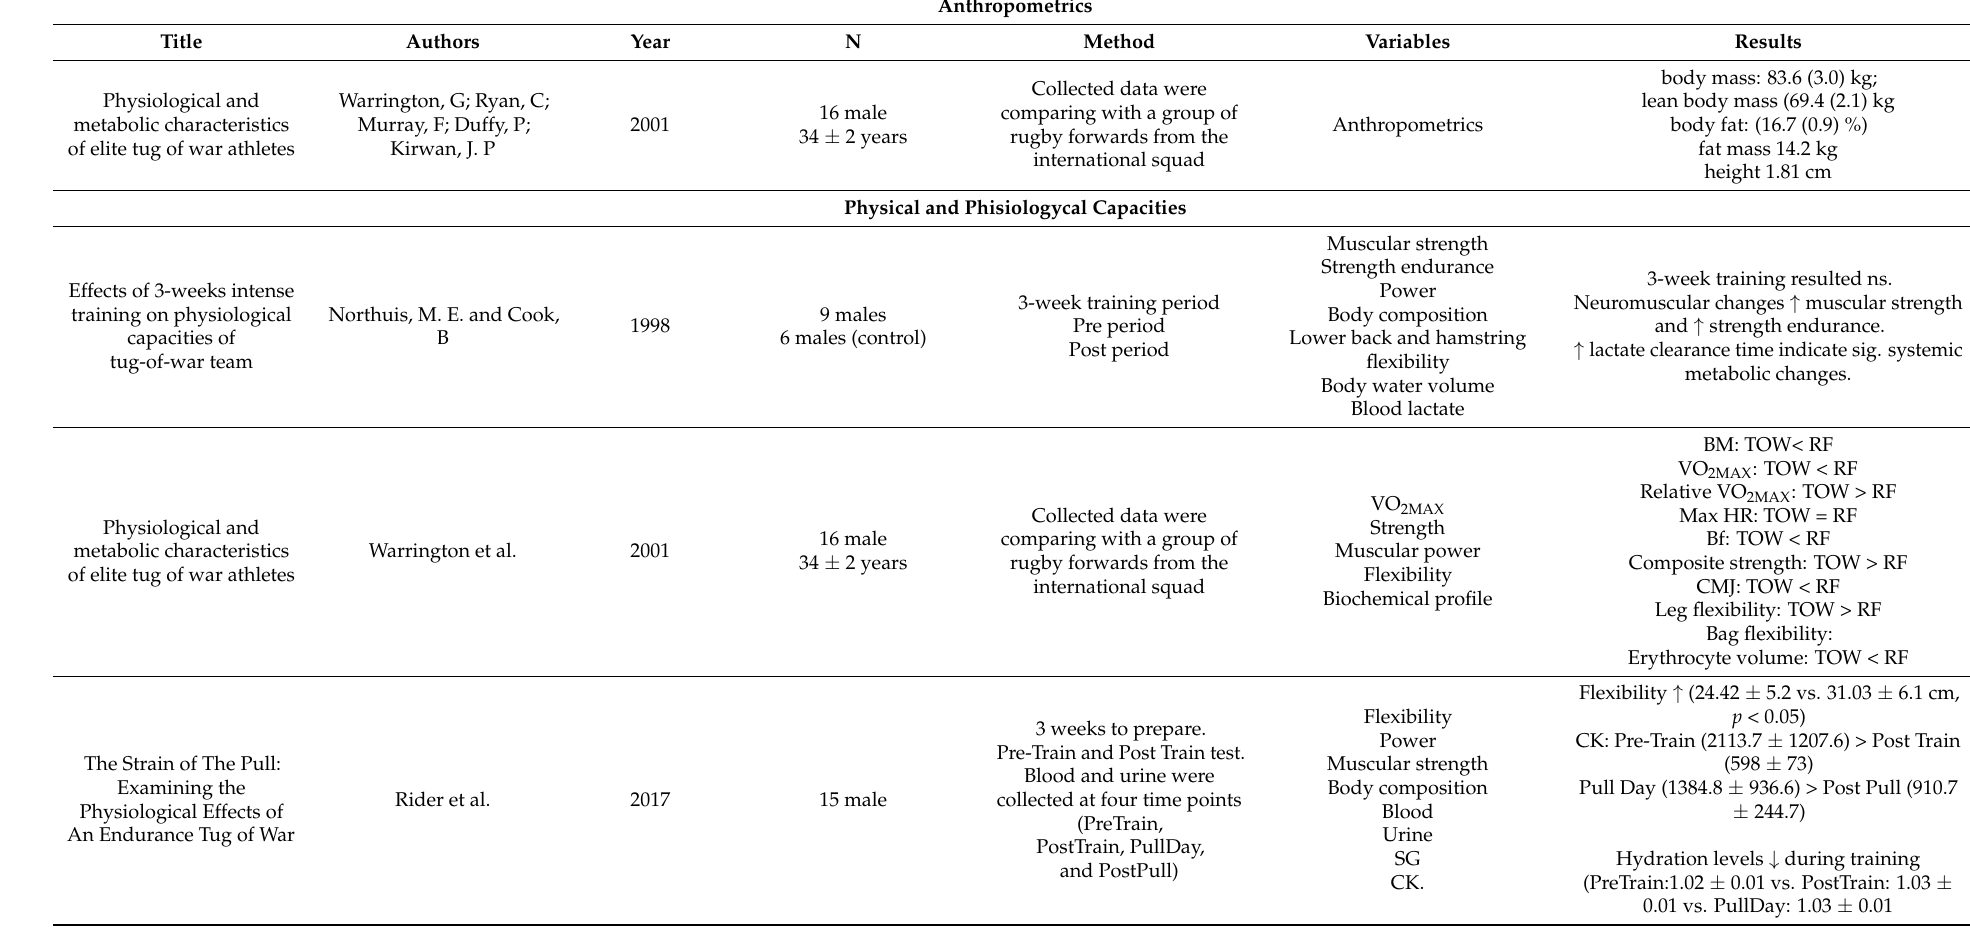
Table 1. Studies published related to Tug of